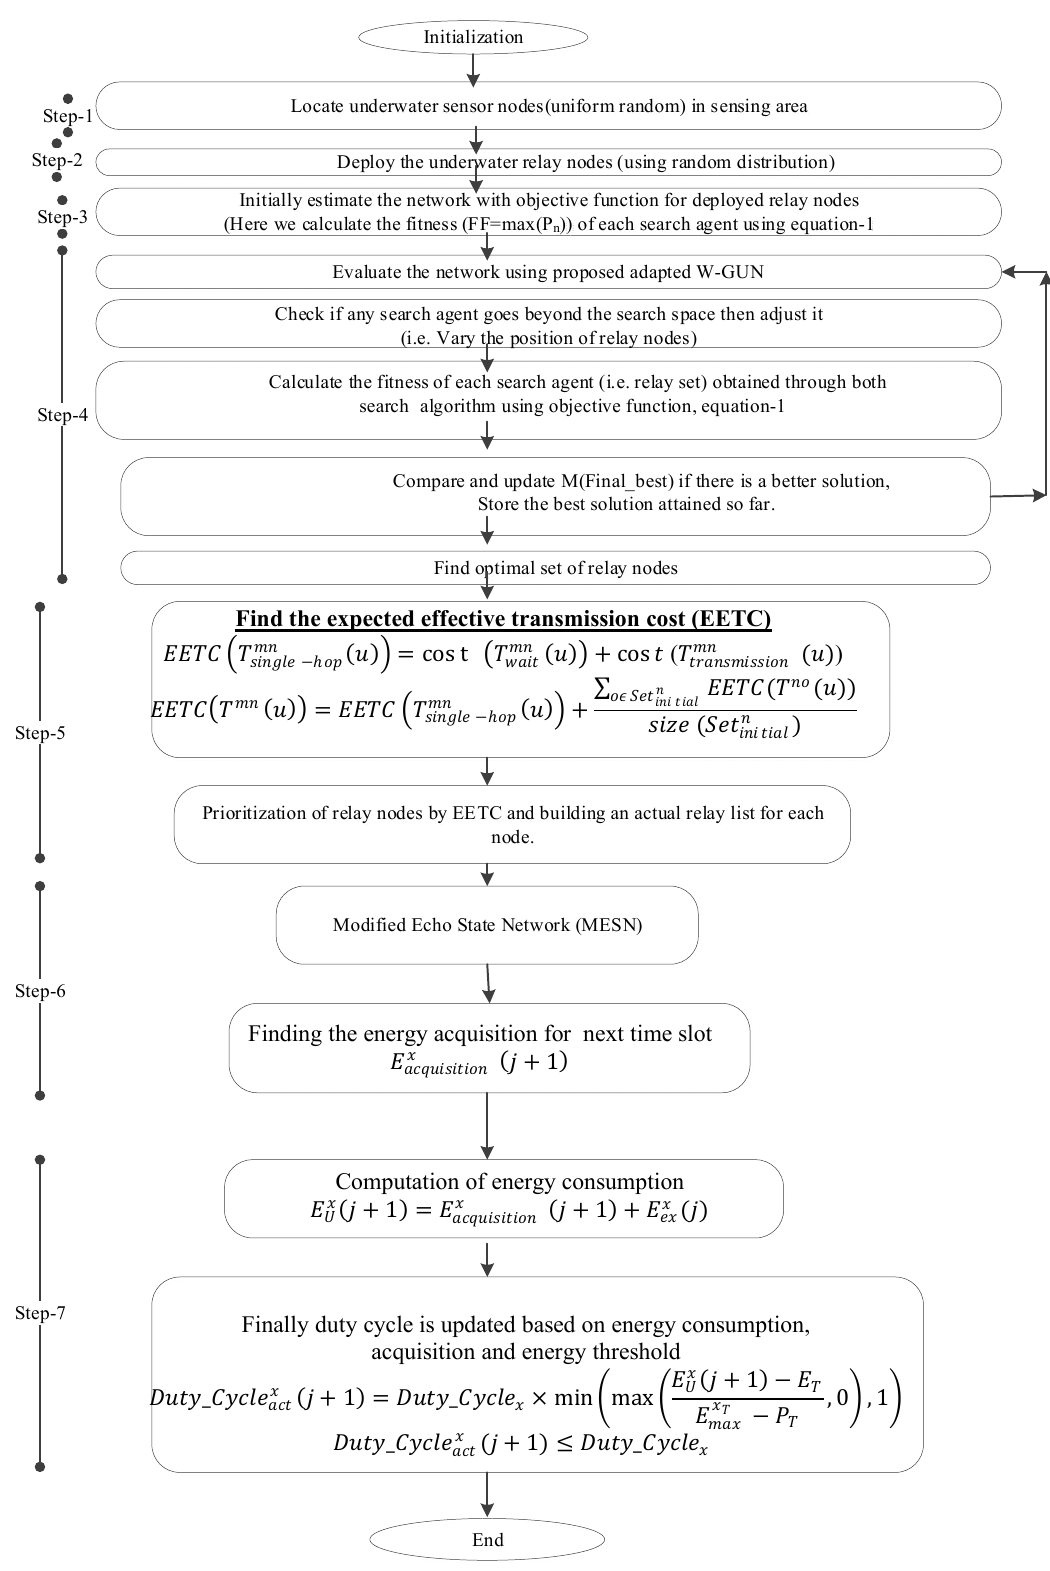
Figure 2. The working structure of proposed adapted relay node optimization framework W-GUN.